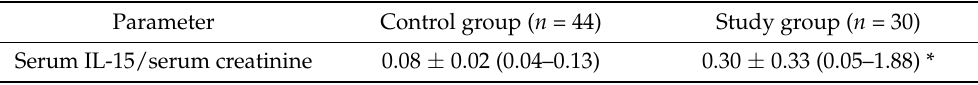
Table 3. Serum IL-15 to serum creatinine ratio for study and control group. Parameter Control group ( n = 44) Study group ( n = 30) Serum IL-15/serum creatinine 0.08 ± 0.02 (0.04–0.13) 0.30 ± 0.33 (0.05–1.88) * Data are presented as the mean ± standard deviation (minimum–maximum). * p <